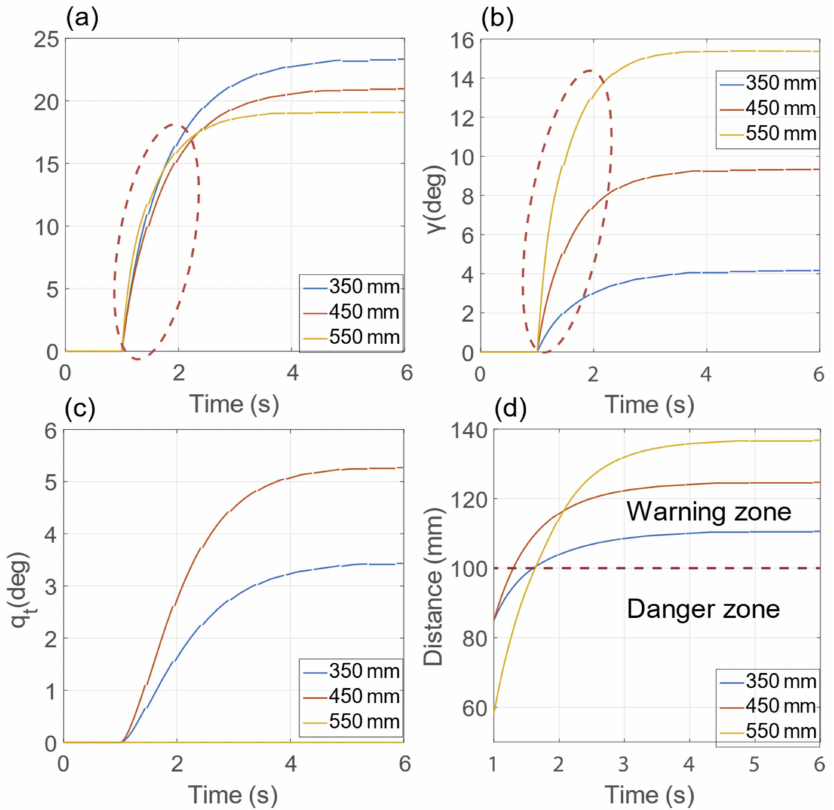
Figure 11. Dynamic evolution of the y ( a ), γ ( b ), q t ( c ) state variables and time response ( d ) of the minimum distance for the three performed simulations with one obstacle.